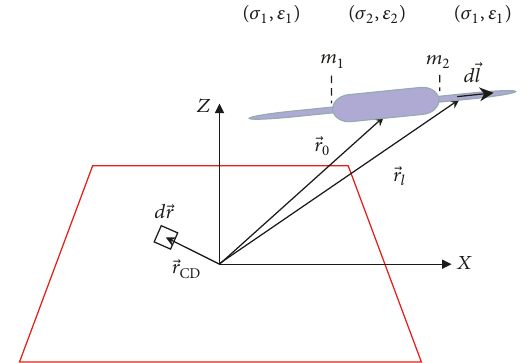
Figure 1: Schematic representation of the coordinates of the CD and a linear molecule type (C).